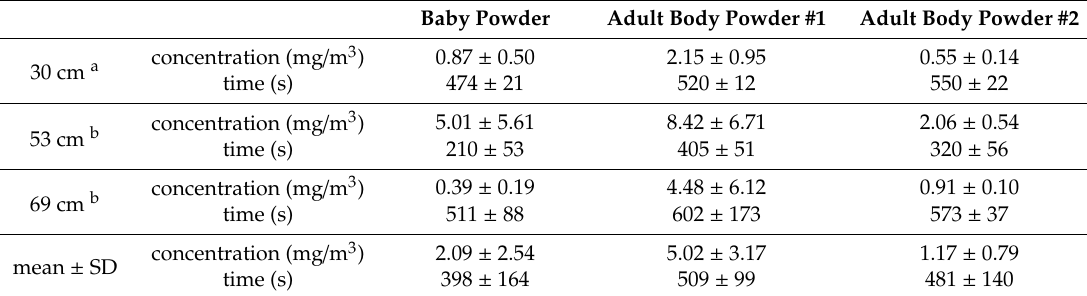
Table 3. Comparison of PM 10 concentration and duration of particle cloud formed by three talc products (one-squeeze application) at varying distances from bottle top, monitored inside a laboratory chamber ( n = 3) at 27 ◦ C and 21% RH. See Table 2 for product characteristics. Baby Powder Adult Body Powder #1 Adult Body Powder #2 concentration (mg / m 3 ) 0.87 ± 0.50 2.15 ± 0.95 0.55 ± 0.14 30 cm a concentration (mg / m 3